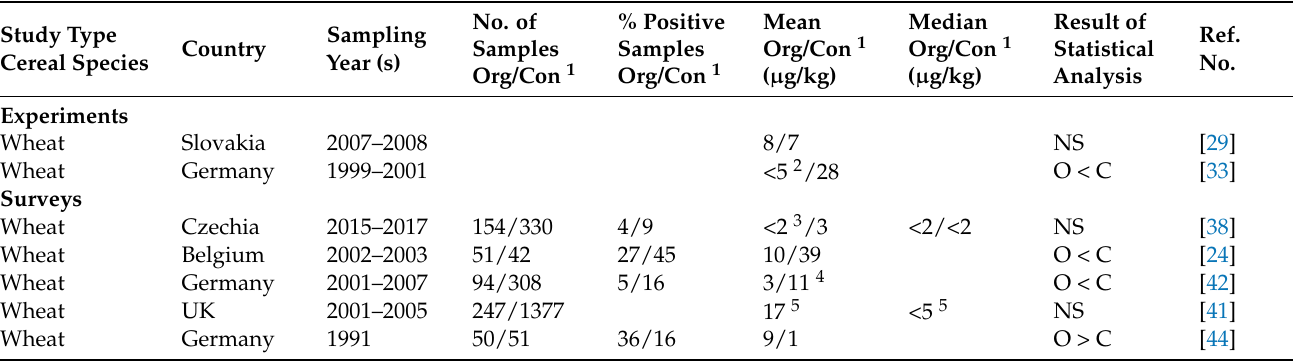
Table 2. Results from field-experiment- and farm-survey-based studies that compared zearalenone (ZEA) concentrations in organically (org) and conventionally (con) produced cereal